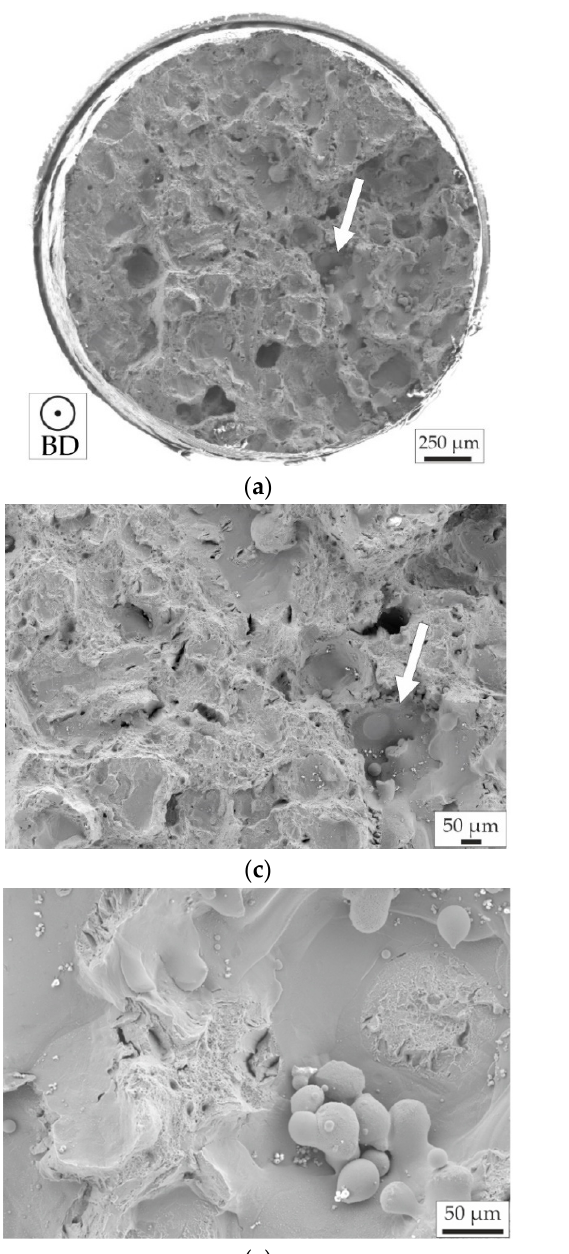
Figure 5. Fracture surfaces under different magnifications of tensile specimens tested parallel ( a , c , e ) and perpendicular ( b , d , f ) to BD showing mixed ductile and brittle fracture. Representative defects indicated by white arrows in ( a – d ) are magnified in ( e , f ).